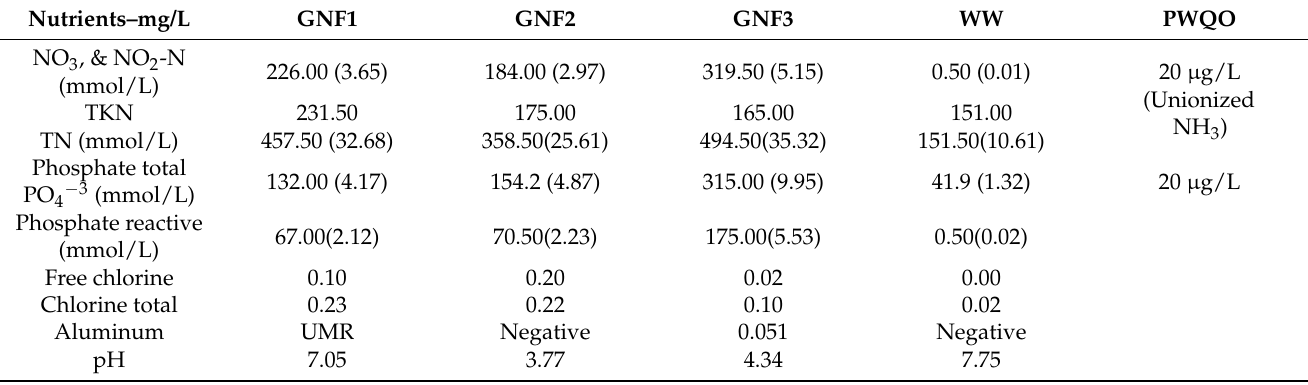
Table 6. Nutrient analysis results for all the GNFs and well water from